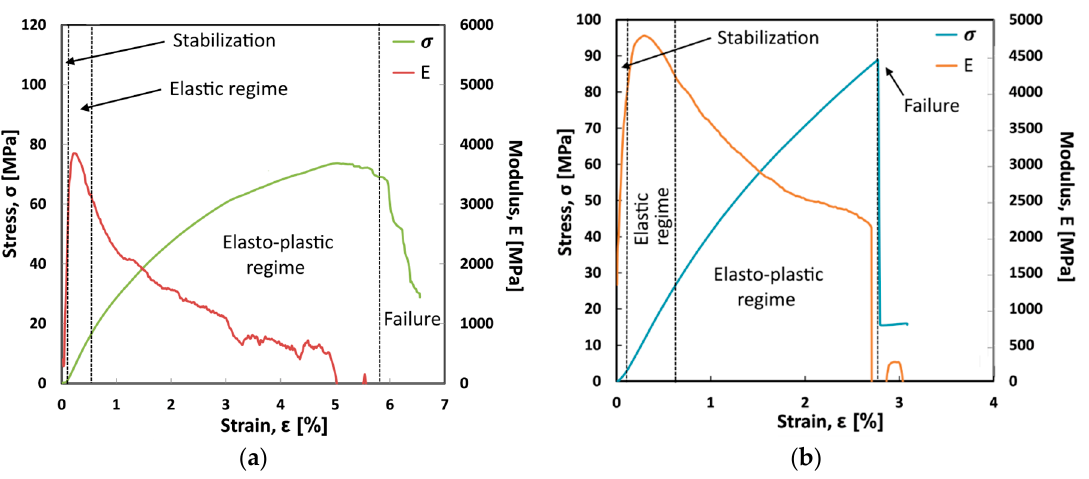
Figure 1. Flexural stress and modulus vs. strain typical curves of ( a ) Flax-AR and ( b ) Jute-AR laminates.